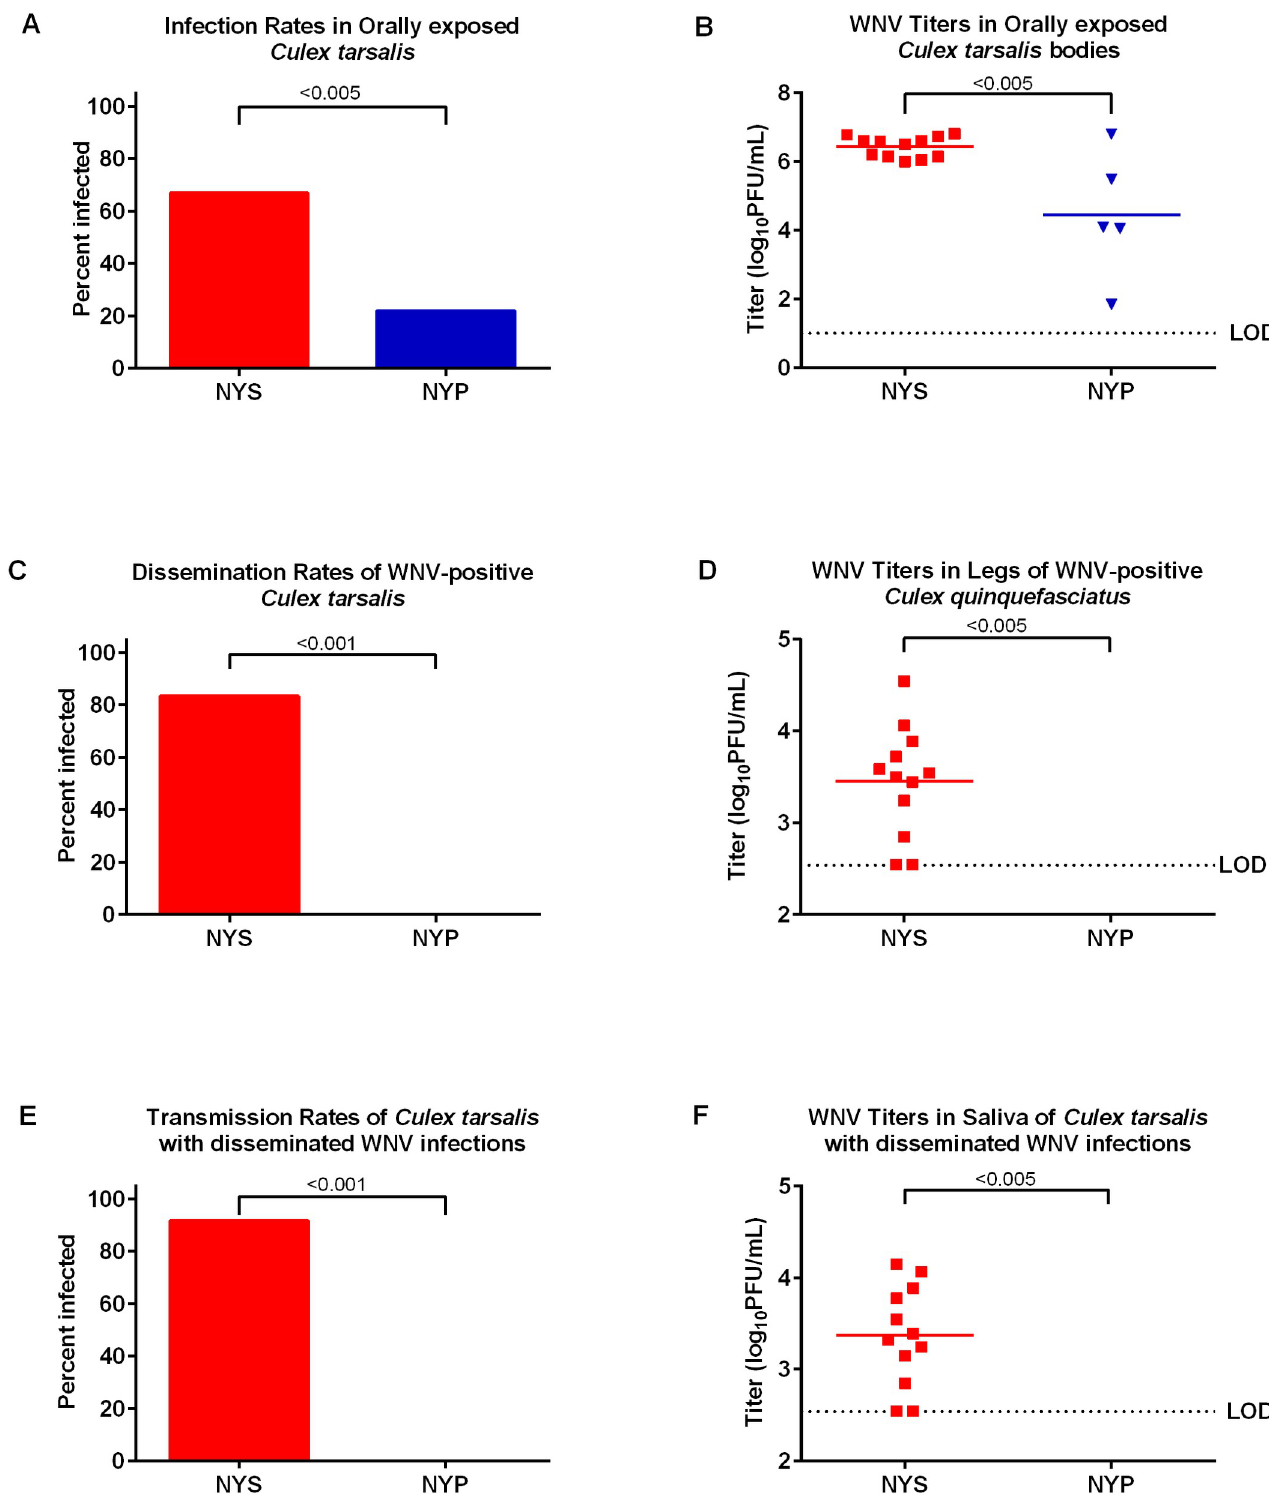
Fig 7. Vector competence assessment of WNV glycosylation mutant viruses in Culex tarsalis . Culex tarsalis were orally exposed to individual artificial blood meals containing 7 log 10 PFU/mL of parental WNV (NYS) or WNV glycosylation mutant virus (NYP). After the extrinsic incubation period of 14 days, bodies, legs and saliva were collected from 25 mosquitoes, mixed with diluent, homogenized and stored until titrations using a standard plaque assay. Figures show (A)